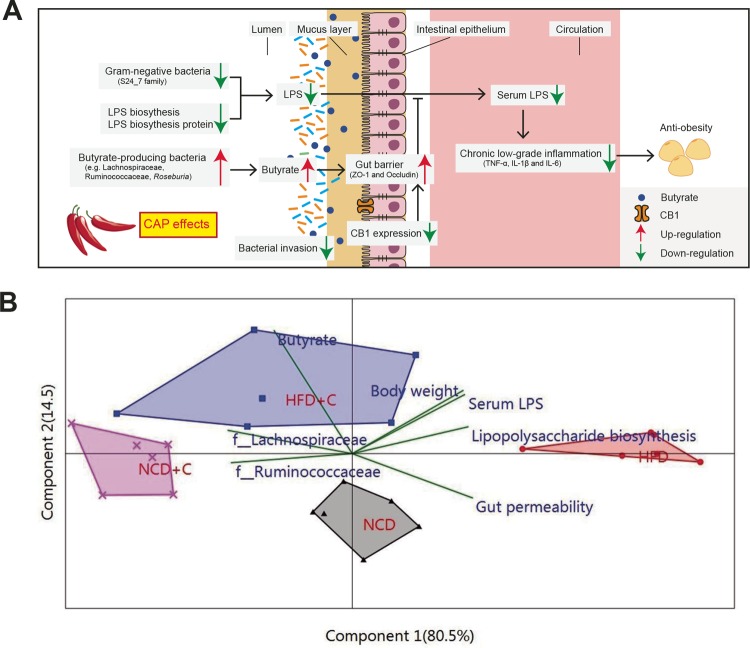
Diagram illustrating a proposed mechanism by which the interactions between dietary CAP and gut microbiome lead to a decrease in Gram-negative LPS-producing bacteria (e.g., S24-7 family) and LPS biosynthesis and an increase in butyrate-producing bacteria (e.g., Lachnospiraceae and Ruminococcaceae) and butyrate levels. These changes lower LPS production and gut permeability and downregulate CB1 expression, resulting in reduced markers of metabolic endotoxemia. The subsequent reduction of inflammatory cytokines leads to the suppression of chronic low-grade inflammation and obesity (A). (B) Principal-component analysis (biplot) showing the correlation between important parameters of the proposed mechanism presented above. Labels indicate the four groups. The names of the parameters are plotted as vectors according to their correlation to the first two components.